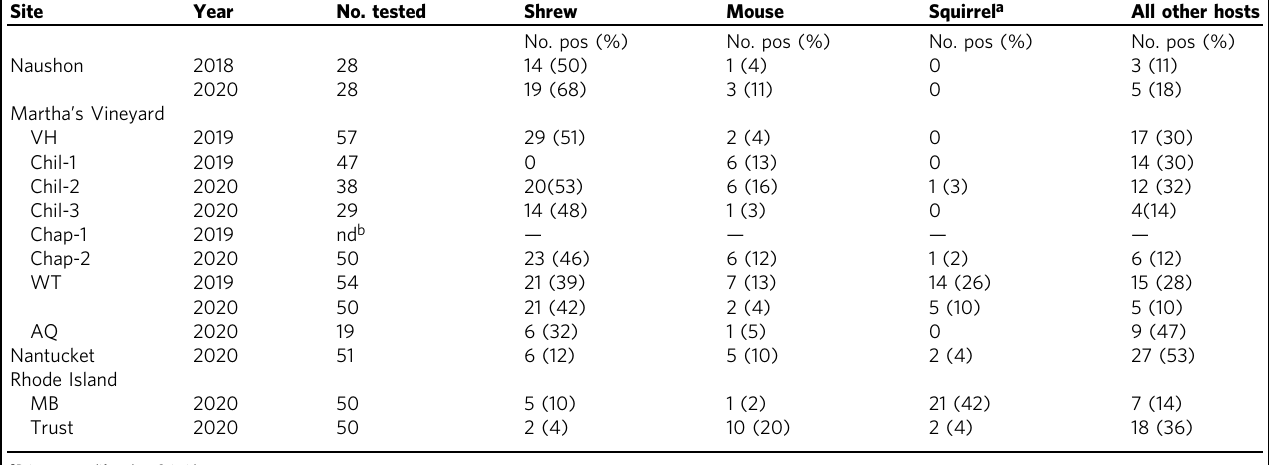
Table 4 The percentage of ticks at each site that tested positive for having fed on either a shrew ( Soricidae ), mouse ( Peromyscus ), squirrel ( Sciuridae ), or all other hosts tested ( Odocoileus, Aves, Felis, Arvicolinae , or Lagomorpha ).